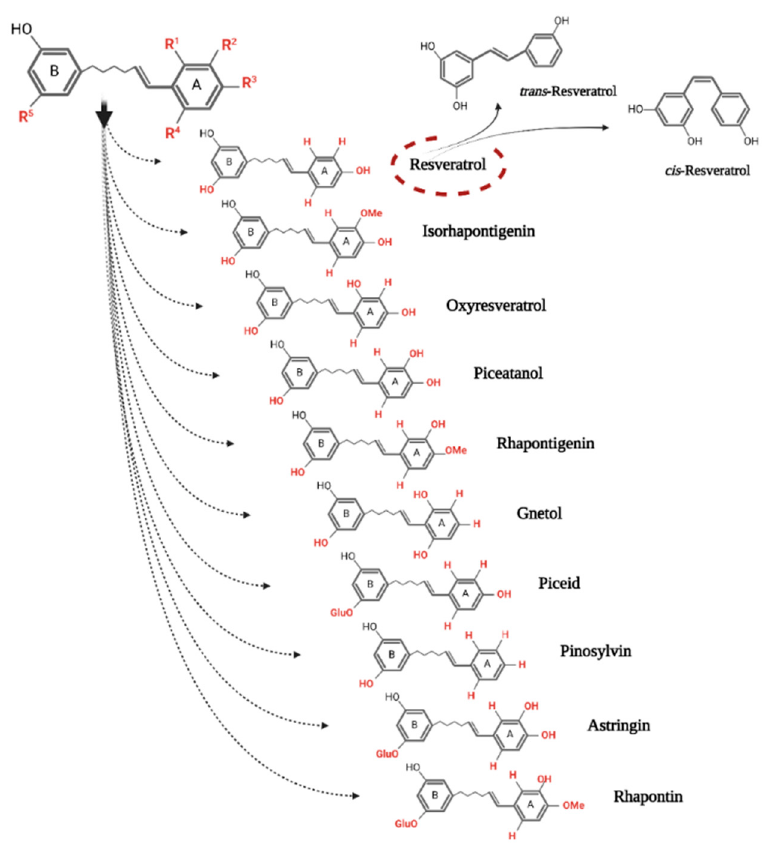
Figure 1. The chemical structure of the two conformations of resveratrol and its main monomeric derivatives.